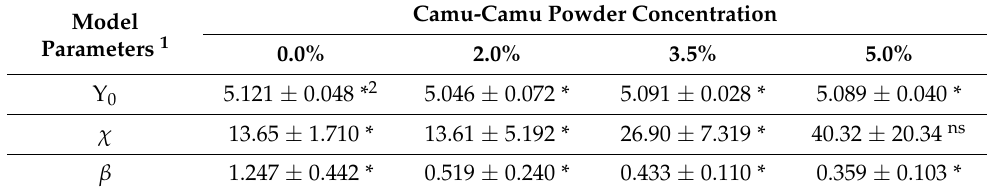
Table 5. Kinetic parameters of the Weibull decay model describing S. enterica ser. Typhimurium behavior in vacuum-packed ground beef containing different camu-camu powder levels stored at